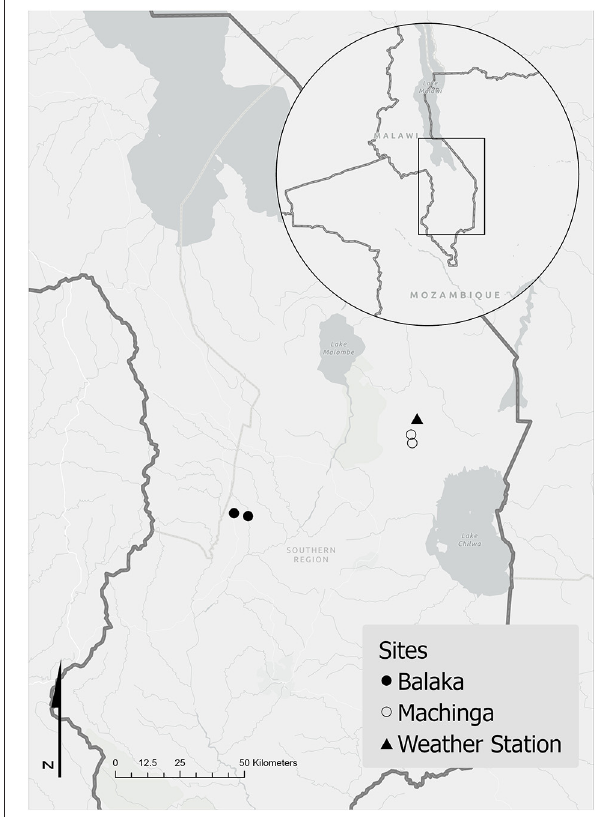
FIGURE 1 | Study sites within